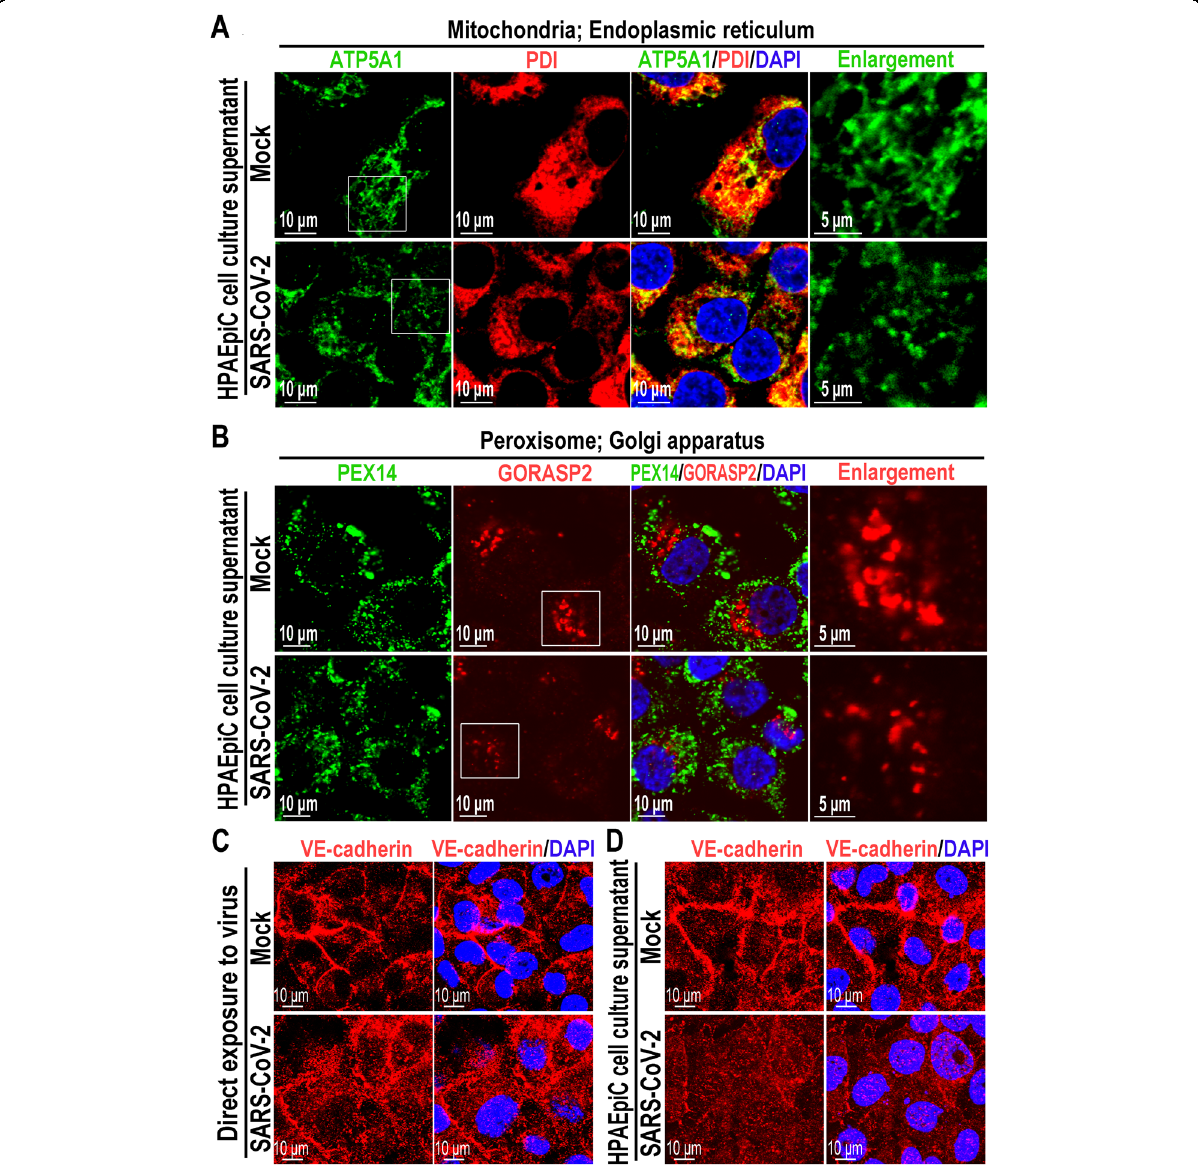
Fig. 3 Organelles of HULEC-5a cells following treatment with culture supernatants from mock- or SARS-CoV-2-infected HPAEpiC cells. a Representative images of mitochondria and endoplasmic reticulum in HULEC-5a cells treated with mock- or SARS-CoV-2-infected HPAEpiC cell culture supernatants. The mitochondria indicated by white box were enlarged on the right. b Representative images of peroxisomes and Golgi apparatus in HULEC-5a cells treated with mock- or SARS-CoV-2-infected HPAEpiC cell culture supernatants. The Golgi apparatus indicated by white box was enlarged on the right. c Representative images of adherent junctions visualized by VE-cadherin in Mock- or SARS-CoV-2-infected HULEC-5a cells. d Representative images of adherent junctions visualized by VE-cadherin in HULEC-5a cells treated with mock- or SARS-CoV-2-infected HPAEpiC cell culture supernatants. All results represent three independent